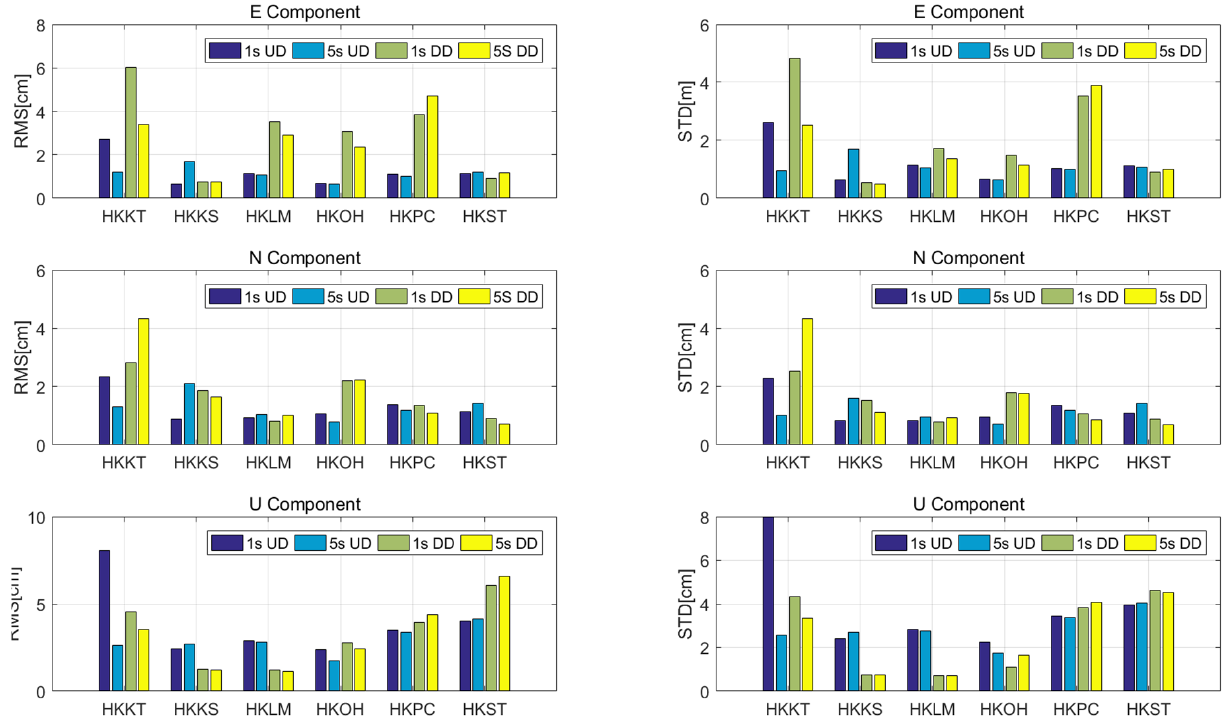
Figure 7. RMS and STD for different baselines. Table 4. RMS and STD improvement rate on ENU.